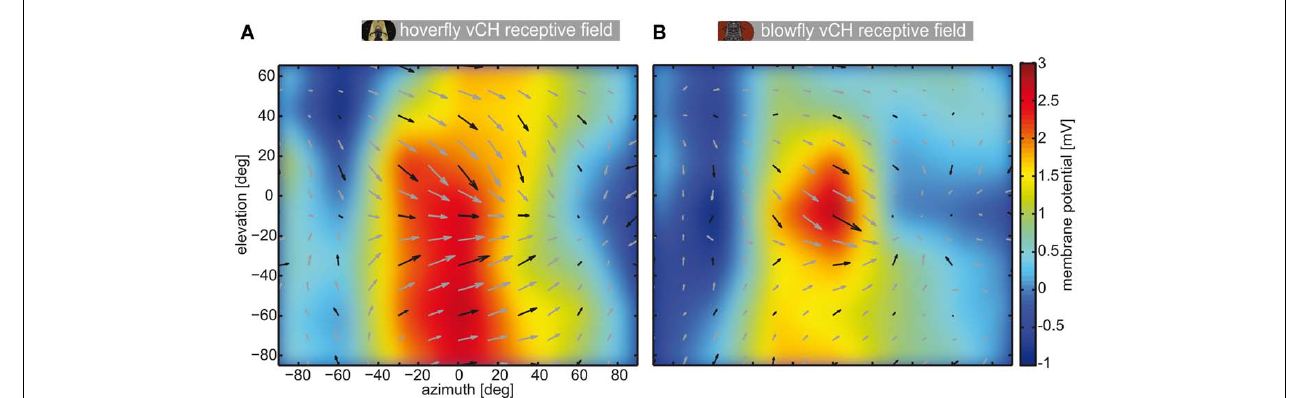
as follows: At first we corrected for the latencies of the cells.We calculated the latency from the replay experiments (see Materials and Methods), by calculating the mean time difference between the saccade velocity peak and the response amplitude peak. For each movement direction adopted by our bar stimulus (left to right, right to left, top to bottom, bottom to top) we calculated the mean response across cells.We treated the membrane potential change as the length of a vector pointing in the direction of target motion. Summation of all four vectors yielded the preferred direction vector.The length of this vector was set to represent the local direction sensitivity.This was done at all locations within the sampling grid.The color map behind the local preferences shows the mean interpolated reaction of the cells to left-to-right motion. (A) Receptive field of Eristalis vCH ( n = 3), (B) receptive field of Calliphora vCH ( n =